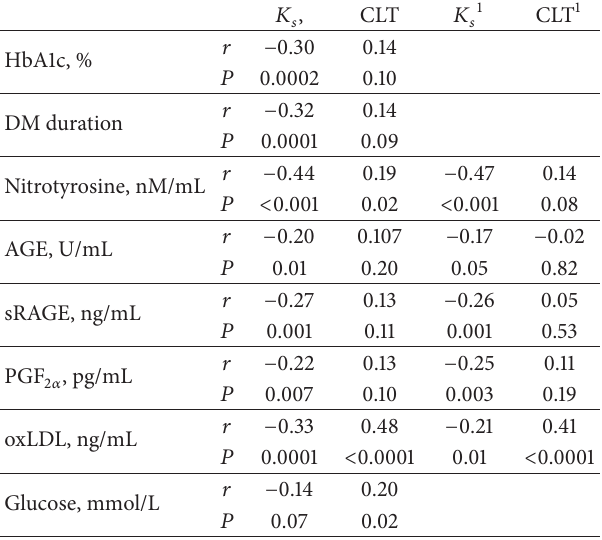
Table 3: Univariate correlations of clot permeability ( 𝐾 𝑠 , 10 −9 cm 2 ) and clot lysis time (CLT, min).